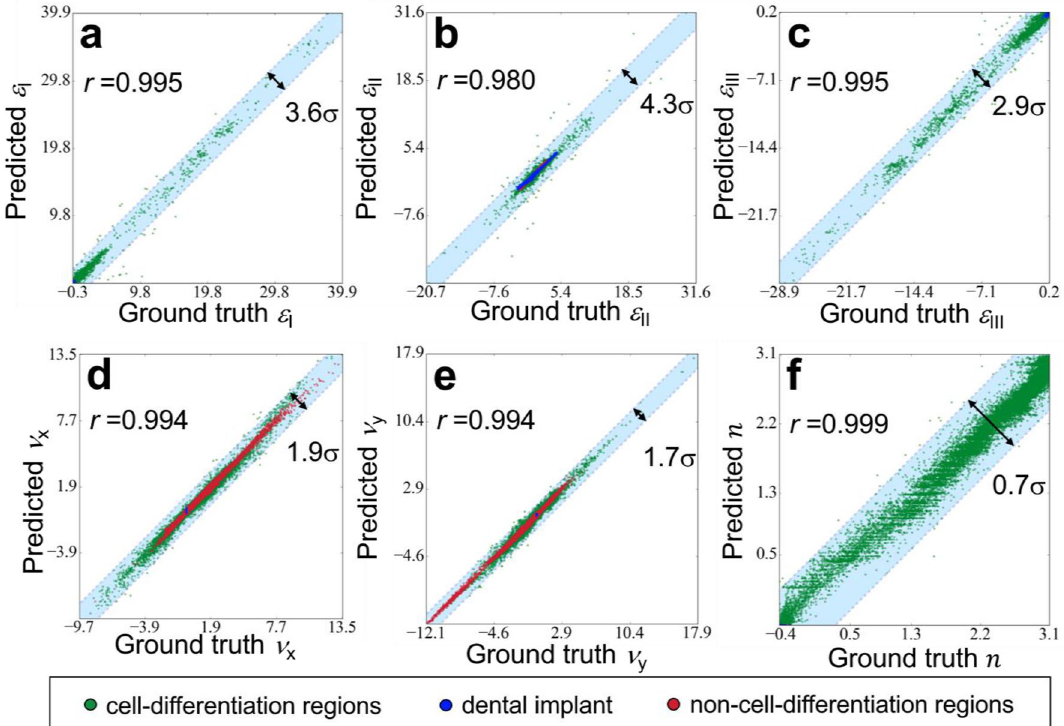
Figure 2. The predicted values vs. ground truth of the six physical properties, principle strain I ( ε I ), II ( ε II ), and III ( ε III ), the fluid velocity in the x and y directions ( ν x , ν y ) and stem cell concentration ( n ), for every pixel throughout 35 days in the 14 implants. Where blue, red, and green dots represented the data from pixels located in dental implant, non-cell-differentiation, and cell-differentiation regions, respectively.